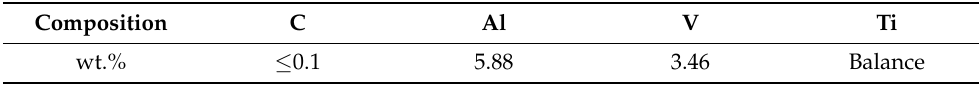
Figure 1. Cross-sectional microstructures of CCF30/PEEK sheet. ( a ) Macro image of the utilized CCF30/PEEK plates in experiments. ( b ) SEM images of the cross-sectional morphologies of CCF30/PEEK plates. Table 1. Normal chemical compositions of titanium alloy Ti6Al4V.